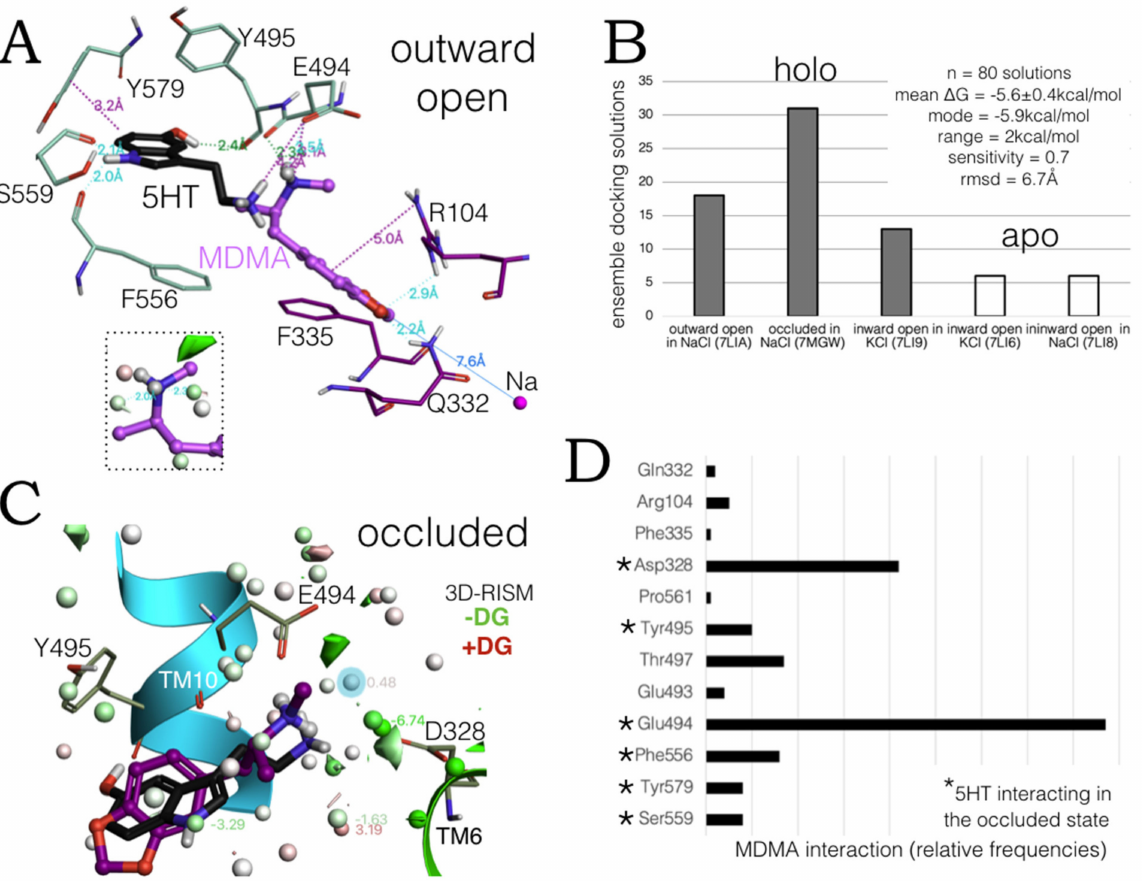
Figure 4. Ensemble binding space analysis of MDMA at the allosteric site of the hSERT. ( A ) Induced fit model of MDMA binding to the holo outward open state obtained in complex with 5-HT (in black). The sodium ion located between TM segments 1a and 1b is shown. Dotted lines represent intermolecular bonds associated to their distances. Ionic and aromatic bonds (in purple) and H- bonds (in cyan = weak, green = strong) are associated to their distances. The 3D-RISM solvation of the methylammonium group of MDMA is shown in the insert. ( B ) Number of energetically favourable MDMA poses per hSERT structure on S2. PDB codes are given in parenthesis. ( C ) The most representative binding pose from the cluster analysis of MDMA (in purple) on the occluded state of the hSERT with 3D-RISM solvation, waters are associated to their ∆ G values. The intact position of 5-HT at S2 is in black. ( D ) Relative occurrences of the repertoire of MDMA interacting residues at the allosteric site. Asterisks denote the residues that interact with 5-HT at S2 on the occluded